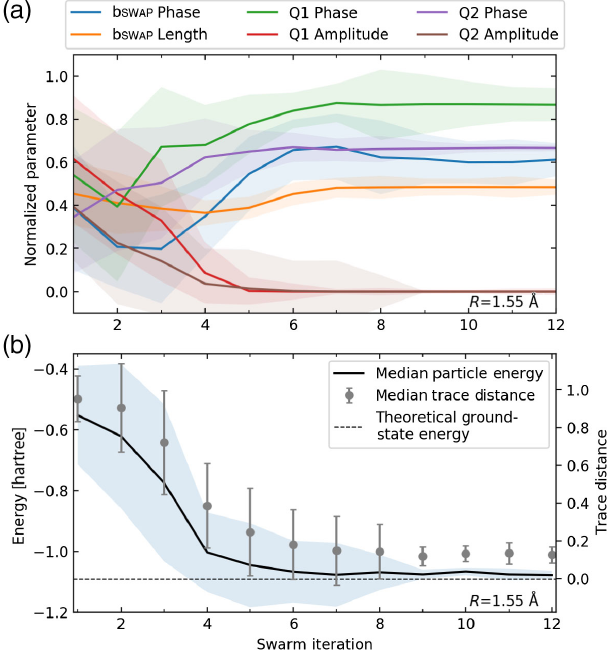
FIG. 2. Control parameter convergence as a function of classical optimizer iteration. (a) Median (solid line) and standard deviation (shaded region) for all six normalized parameter values as a function of swarm iteration number at an internuclear bond distance of 1.55 Å. A swarm of 20 particles demonstrates convergence after approximately 12 iterations or equivalently 240 function evaluations. See SM, VQE and Coherent Errors, for convergence details [28]. (b) Median energy (solid line) and standard deviation (shaded region) of swarm particles as a function of iteration number for the corresponding data in (a). Monotonic convergence of median energy towards the theoretical value is observed followed shortly thereafter by a rapid decrease in swarm energy variance. Trace distance (dots) of the variation- ally prepared ground state as a function of swarm iteration shows reasonable convergence to the theoretically expected ground state. The small remaining discrepancy is most likely due to the flat nature of the energy landscape and unavoidable decoherence during state preparation and